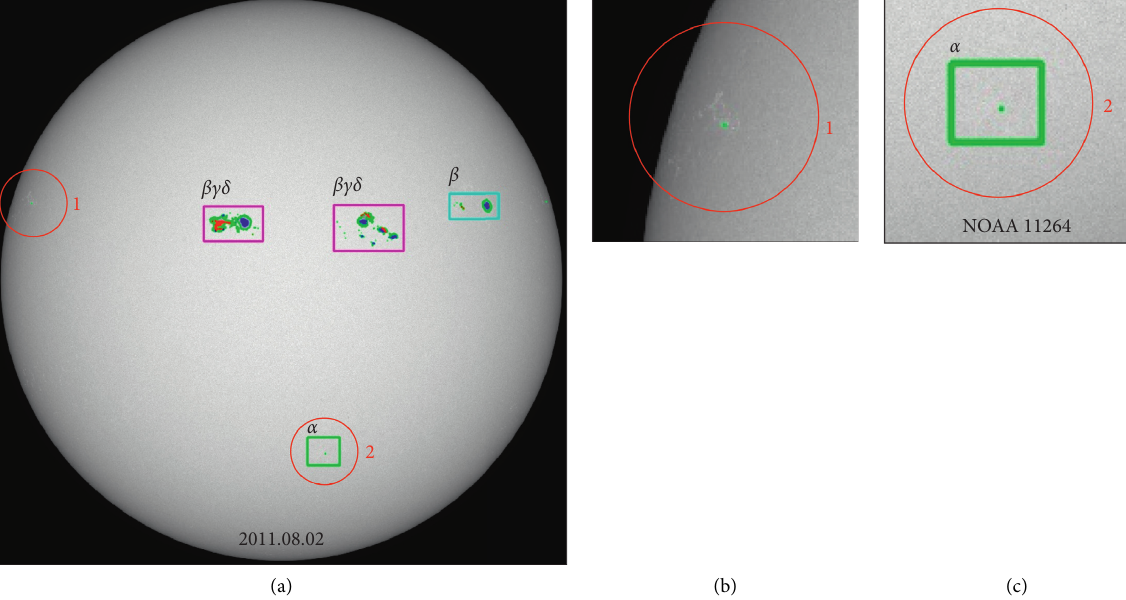
Figure 11: Detection results by our method at 20:00:00 UTon 2 August 2011. (a) The detection results of the composited solar full image. The region with a red circle labeled as 1 is not detected, which is zoomed in (b). The region labeled as 2 is detected, which is zoomed in (c).